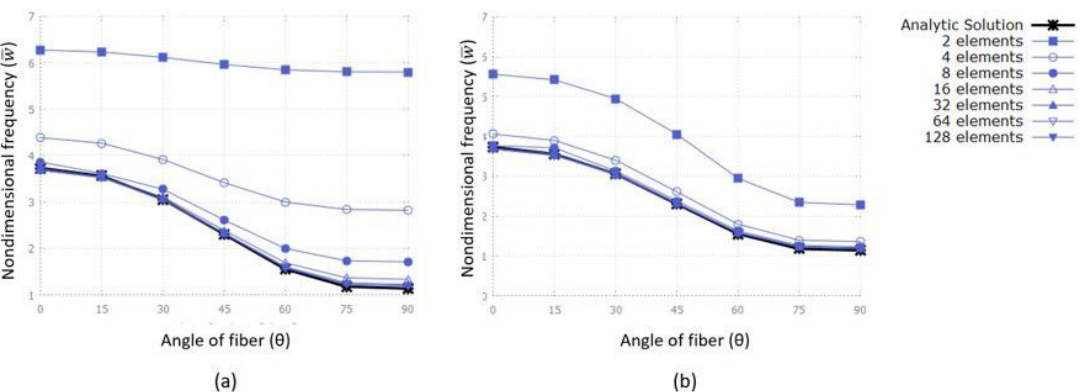
Figure 10. ( a ) First frequency for different ply fiber directions for the clamped-free (CS) beam computed using the parasitic shear finite element model; ( b ) First frequency for different ply fiber directions for the clamped-free (CS) beam computed using the corrected finite element model. Table 8. Error values in the first natural frequency (CS).